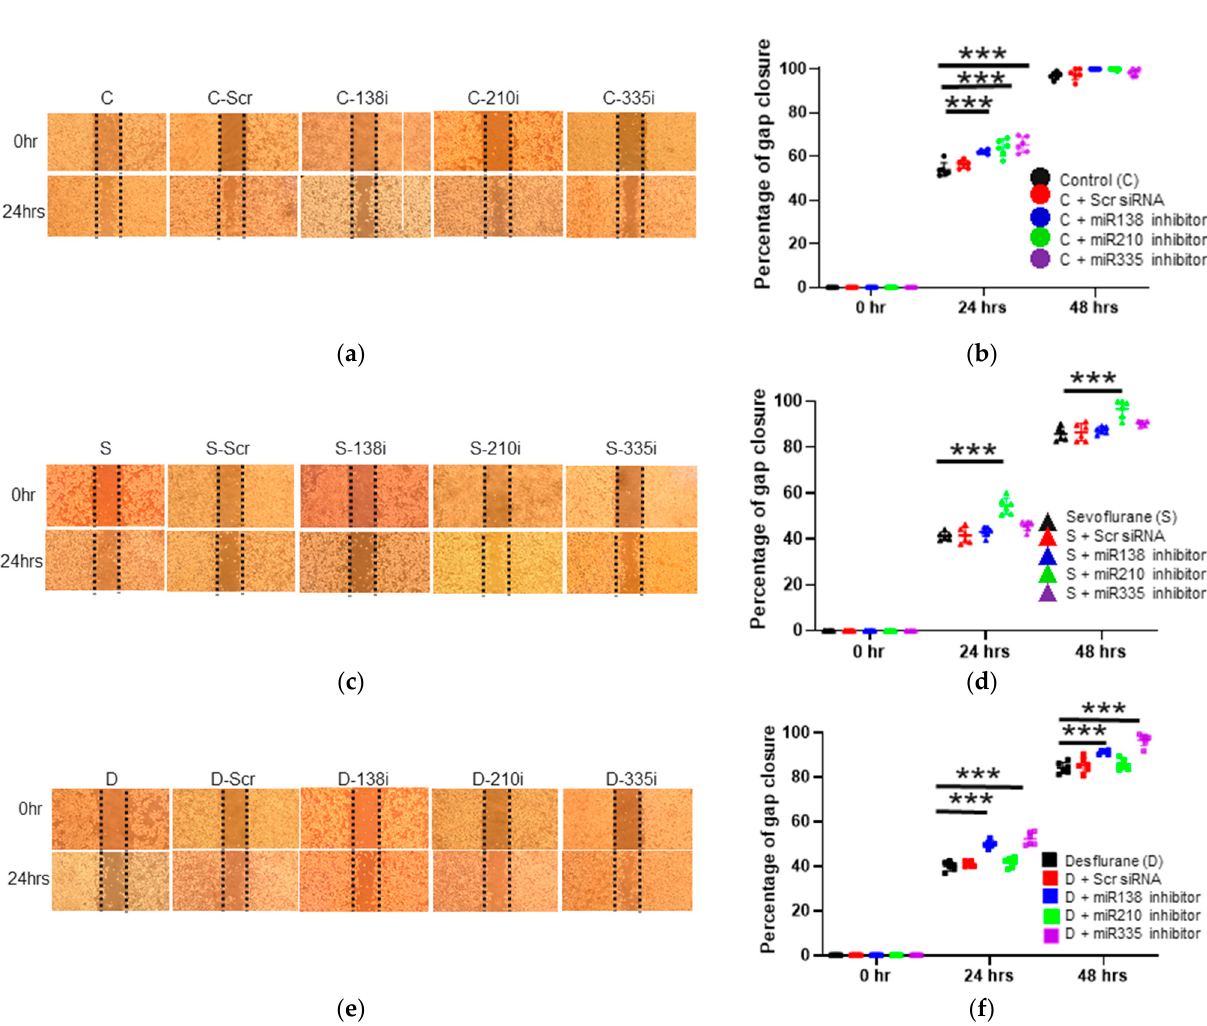
Figure 2. The changes of cell migration after inhalational anesthesia with miRNA inhibitor pretreatment. ( a – f ) Neuroglioma (H4) cell migration analysis with wound healing assay after 24 h and 48 h of inhalational anesthesia with miRNA inhibition pretreatment at 0 h (upper) and 24 h (bottom) after anesthesia. ( a ) The microscopic images after control anesthesia. ( b ) The comparison of gap closure percentage with control anesthesia and miRNA inhibitor pretreatment. ( c ) The microscopic images after 3.6% sevoflurane anesthesia with miRNA inhibitor pretreatment. ( d ) The comparison of gap closure percentage with 3.6% sevoflurane anesthesia and miRNA inhibitor pretreatment. ( e ) The microscopic images after 10.4% desflurane anesthesia with miRNA inhibitor pretreatment. ( f ) The comparison of gap closure percentage with 10.4% desflurane anesthesia and miRNA inhibitor pretreatment. Data showed as plots and mean ± SD (n = 6). *** p < 0.001. One-way ANOVA with Tukey-Kramer compared to each control group. C: control, S: sevoflurane, D: desflurane, Scr: scrambled miRNA, 138i: miR-138 inhibitor, 210i: miR-210 inhibitor and 335i: miR-335